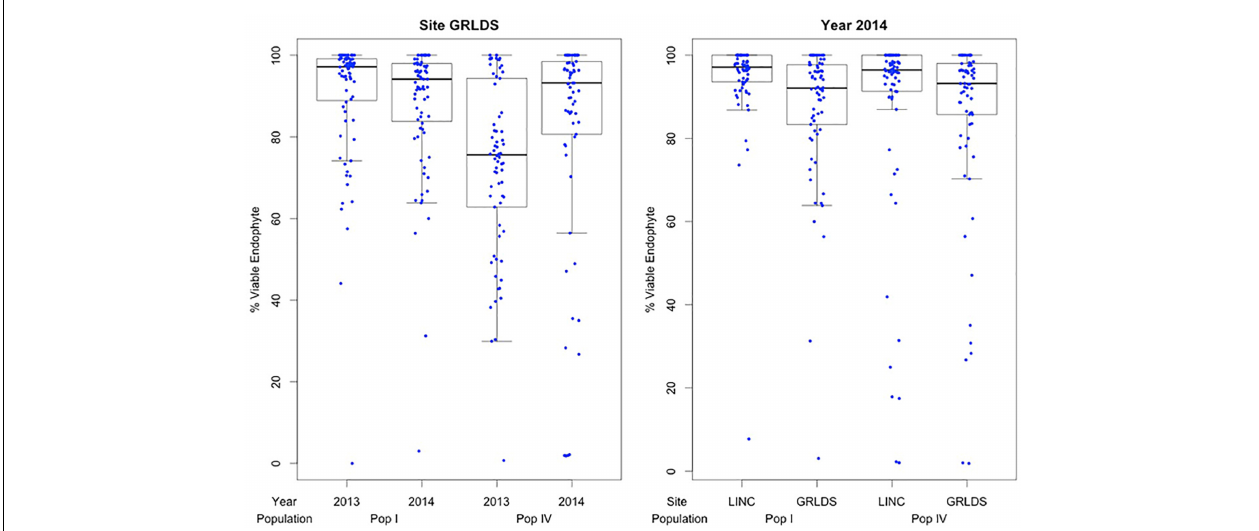
FIGURE 5 | Effects of year and location on AR37 vertical transmission into L. perenne seed. Graphs depict comparisons of AR37 transmission for parental plant genotypes within Populations I and IV grown at the Grasslands Research Centre (GRLDS) for seed harvested in 2013 and 2014 (left), and for AR37 transmission into seed harvested from clonal replicates grown at GRLDS and at the Lincoln Research Centre (LINC) in 2014 (right). Where endophyte infection was lost, data for that parental genotype, including the corresponding location and/or harvest date data, were omitted.